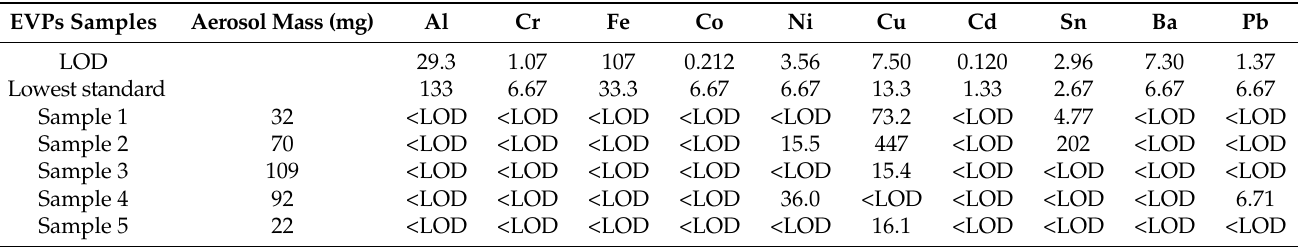
Table 5. Reportable level results obtained of EVP samples in ng/10 puffs.